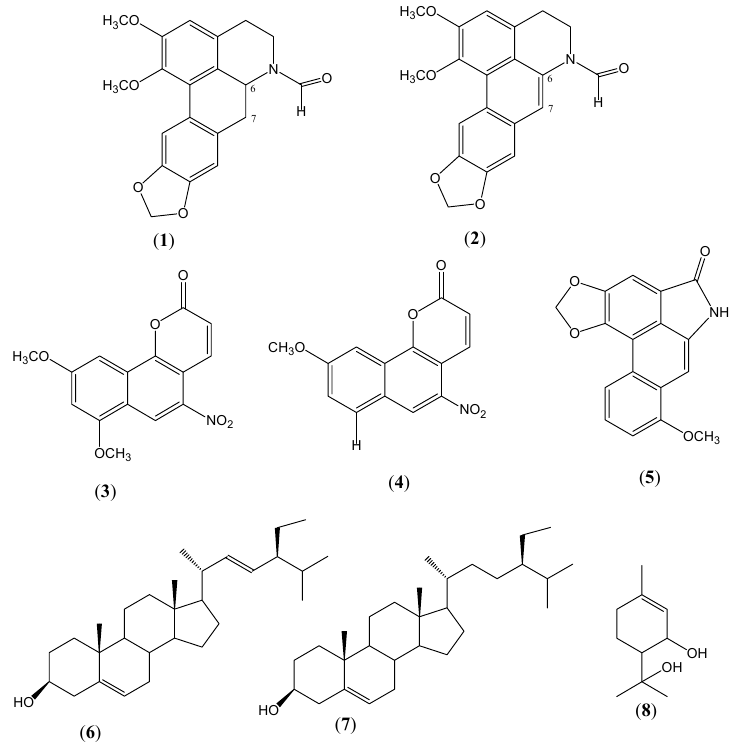
Figure 1. Structure of the compounds from Aristolochia brevipes